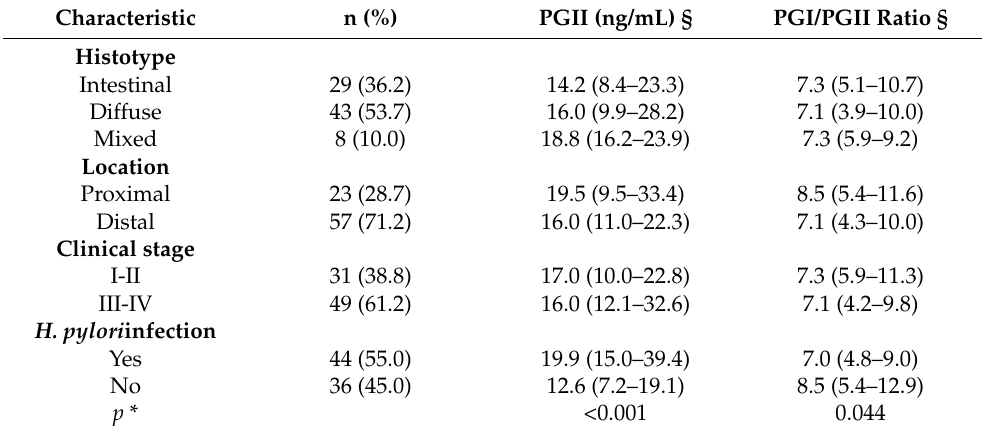
Table 3. Clinical characteristics of the subgroup of 80 patients with gastric